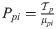
Example of a set of resistance profiles from a system with five strata and four antibiotics.Each row in the table corresponds to the resistance profile of one isolate—i.e. there are three isolates from each strata (equal sampling/size of strata is not necessary). Competitive exclusion within a stratum means all isolates from one stratum have the same resistance profile. The strata have been arranged from top to bottom in order of decreasing resistance proneness (Ppi=Tpμpi). The antibiotics have been arranged left to right in order of increasing resistance threshold (Ta=1γa(1ca-1)), or, equivalently, decreasing resistance frequency. Resistance to a particular antibiotic outcompetes sensitivity in a stratum when the resistance proneness of the stratum is greater than the resistance threshold of the antibiotic. Resistance proneness being independent of antibiotic and resistance threshold being independent of stratum leads to nested resistance profiles (i.e. rarer resistances only observed in the presence of more common ones) and complete linkage disequilibrium between resistances. See Fig A in S1 Text for an example of a set of non-nested resistance profiles.